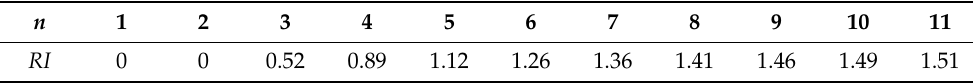
Table 1. Random consensus index ( RI ).